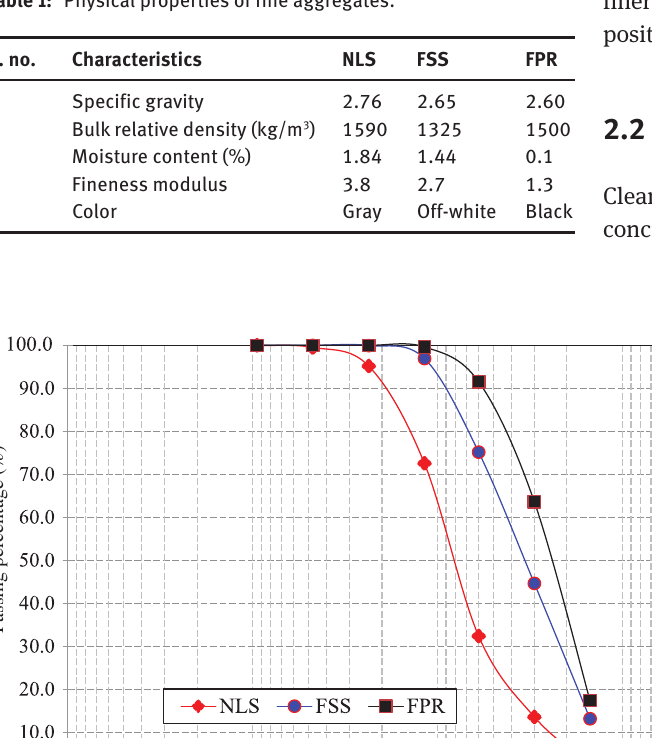
Table 1: Physical properties of fine aggregates.